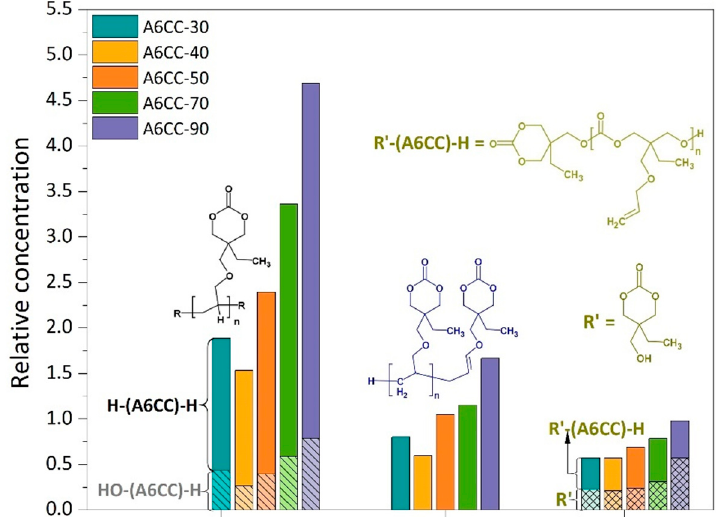
Figure 9. Relative signal intensities to [A6CC + H + ] monomer adducts of the products formed by plasma-induced polymerization (data from Table S1).